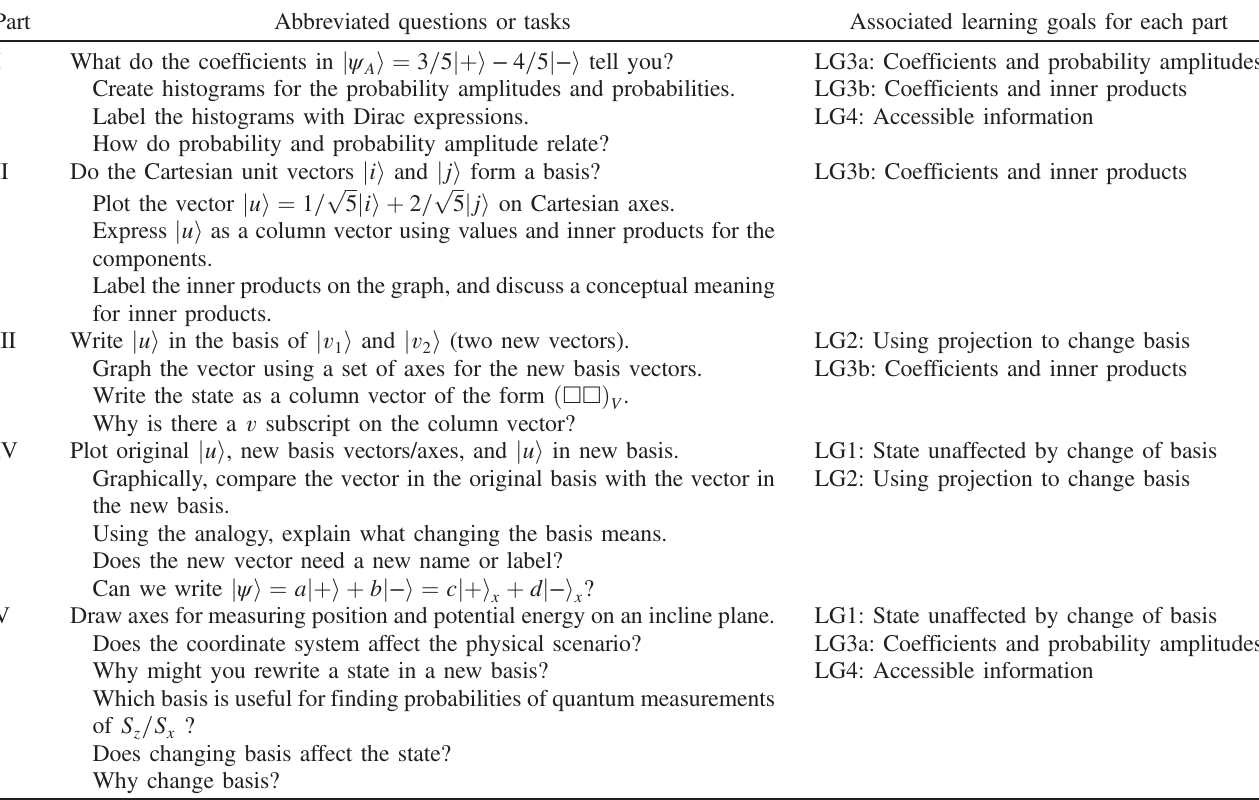
TABLE I. This table presents a summary of each part of the QBT, as well as which learning goals the part targets. Each part fills one printed page, so students have room to write their answers and show their work when needed. The language for the questions or tasks in this table is significantly condensed from the real QBT, and some explanatory text and hints are missing.